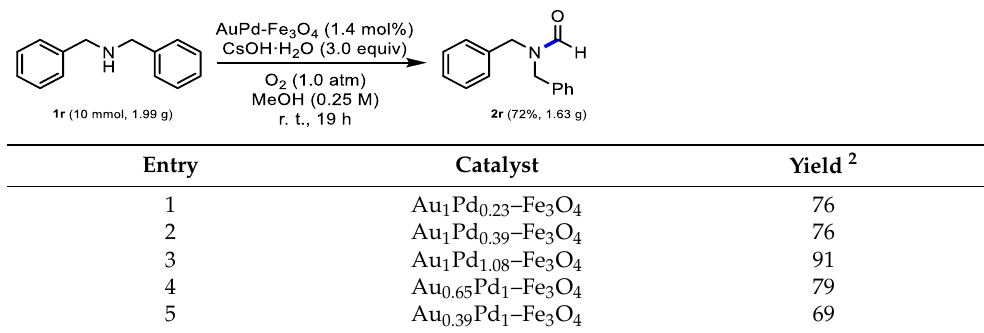
Table 4. Reactivity comparison of various AuPd catalysts 1 .